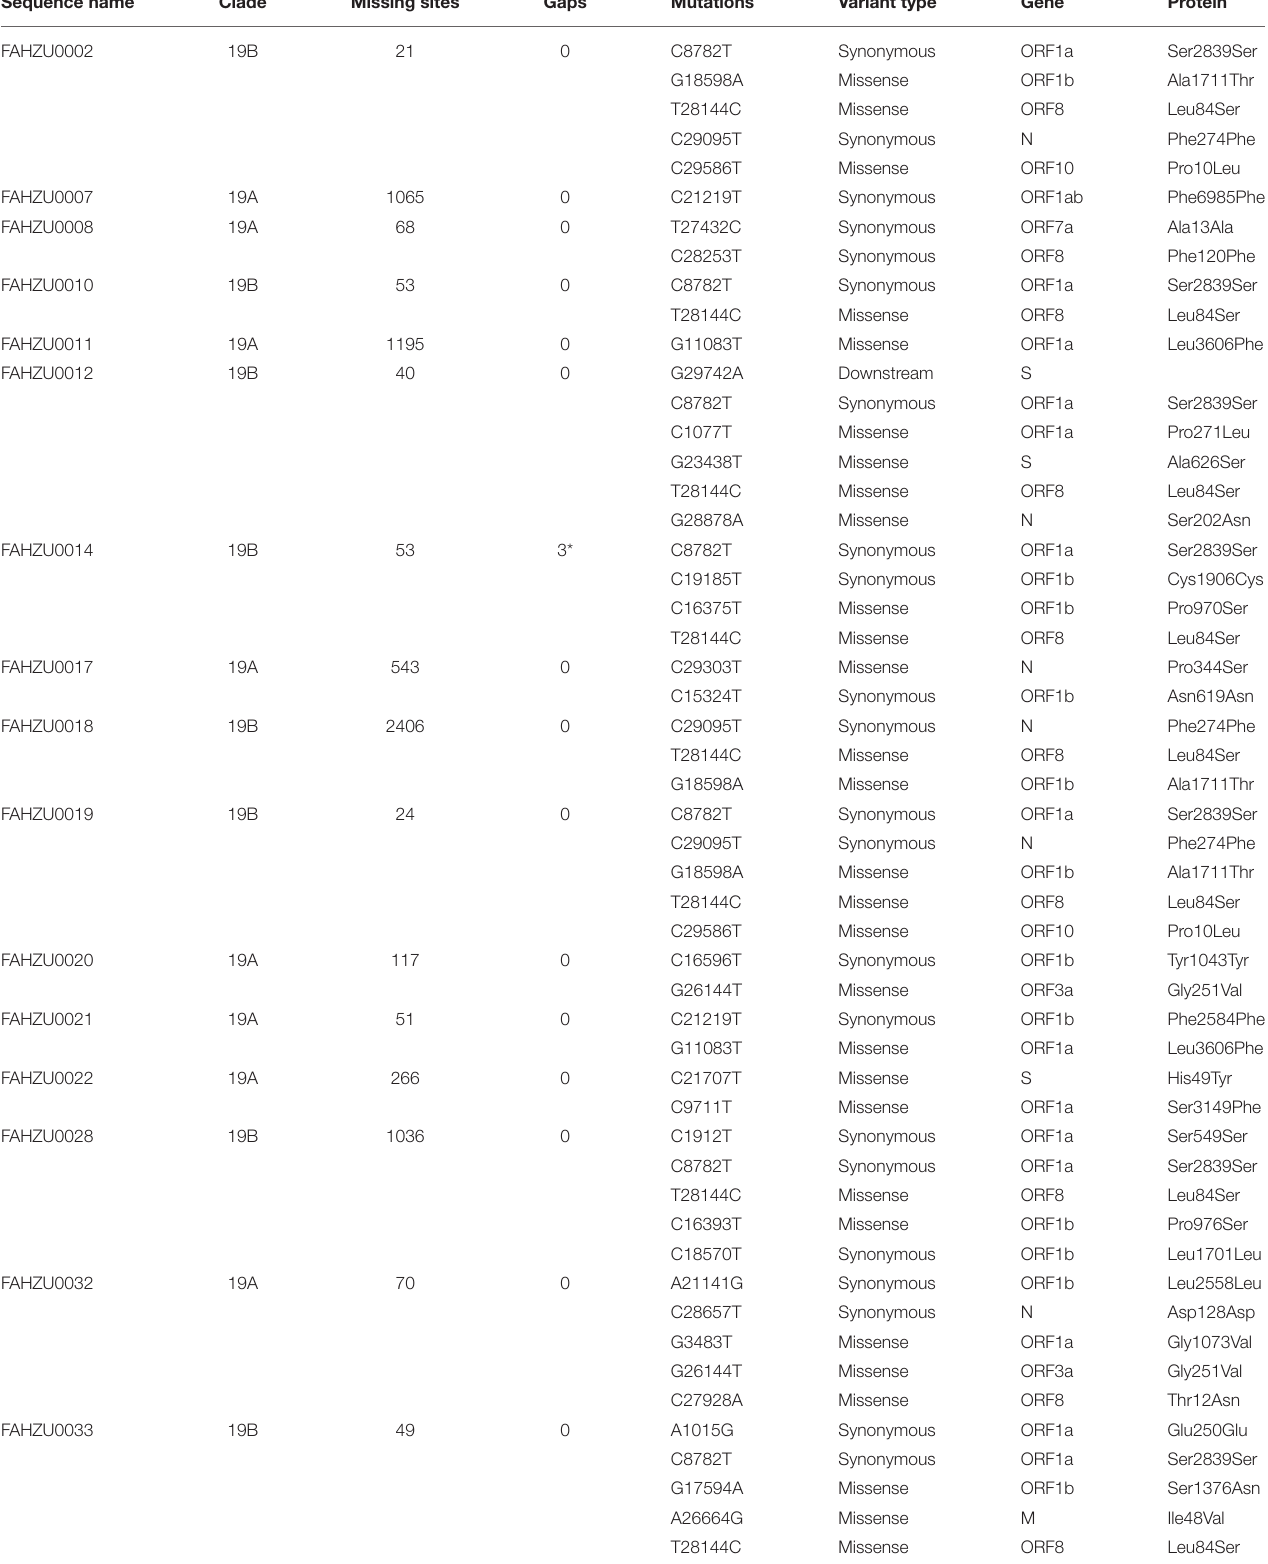
TABLE 1 | Detail information on the SNP in the 19